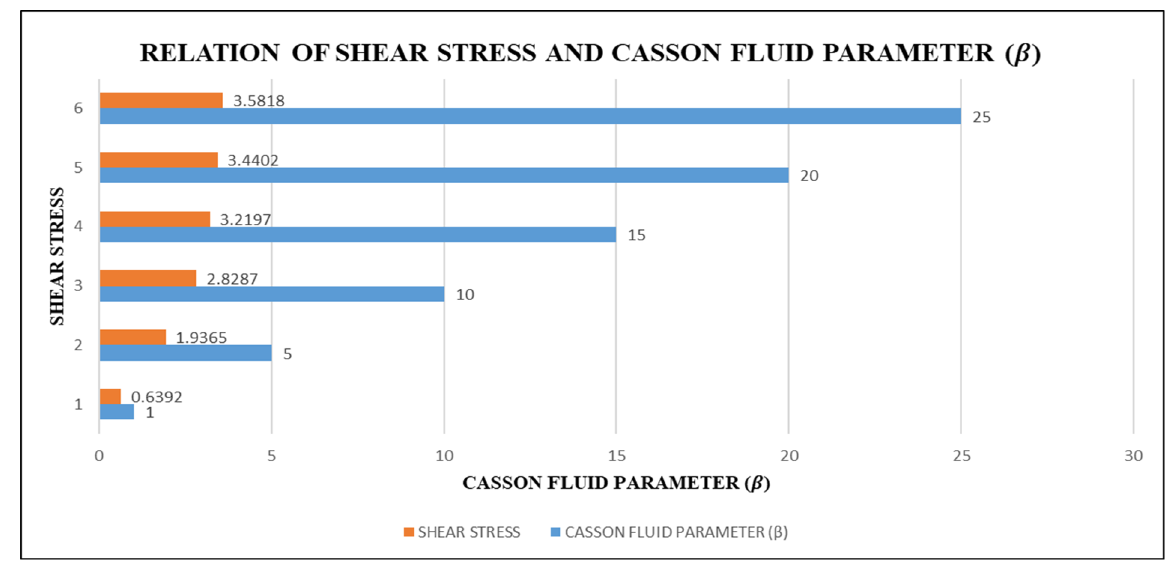
Figure 1. Variation in the behavior of fluid (Newtonian/Non-Newtonian) due to applied shear stress.